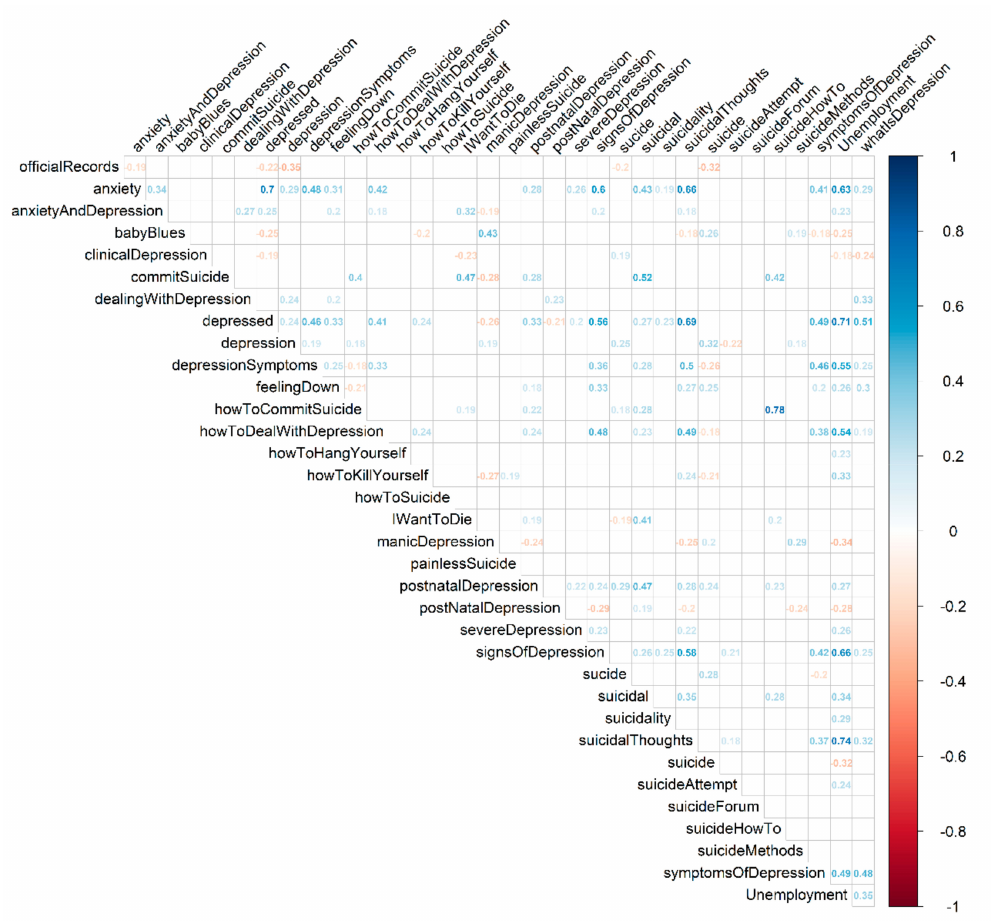
Figure 3. Correlation coe ffi cients for Irish suicide data, Google search queries, and unemployment. The correlation coe ffi cient between the 34 features and the o ffi cial suicide figures are represented using a lag of 24 months. The correlation coe ffi cient value-color correspondence is represented on the bar on the right. Cells without a color are not statistically